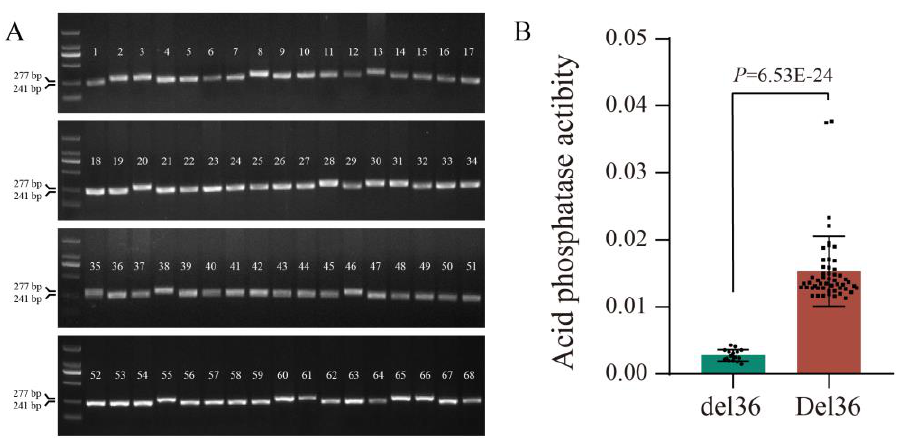
Figure 6. Genotypic and phenotypic analysis of 68 soybean varieties. ( A ) Amplification of GmPAP14 allelic variants in 68 soybean varieties using the marker GmPAP14-intron5-36F/R. ( B ) Comparison of APase activity between two different genotypes. Del36 represents the variant in the fifth intron of G-GmPAP14Z and del36 represents the variant in the fifth intron of G-GmPAP14N . All values represent the means ± SD, n = 3. Error bars represent the SD. A t -test was used to identify the differences between the data.